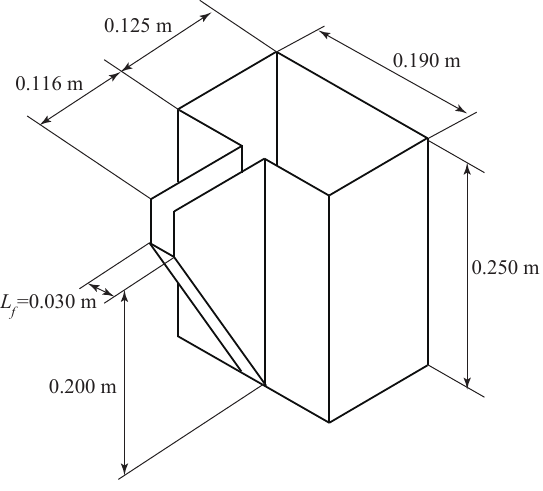
Figure 8. Geometry of ladle (inside